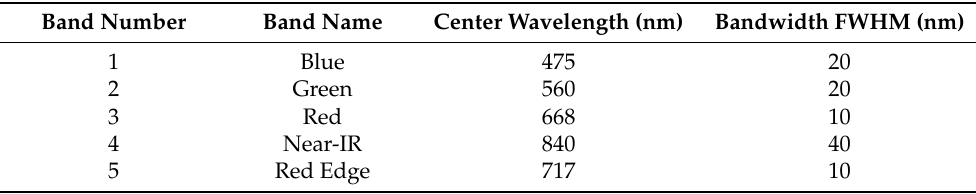
Table 1. Spectral parameters of multispectral